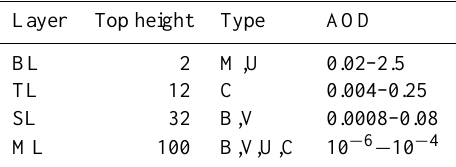
Table B1. Aerosol layers used in SCIATRAN scenarios. BL, TL, SL and ML stand for boundary, tropospheric, stratospheric and meso- spheric layers. The aerosol types are the maritime (M), continental (C), urban (U), stratospheric background (B) and volcanic aerosol type defined in the WMO report (Deepak and Gerber, 1983; Bolle,